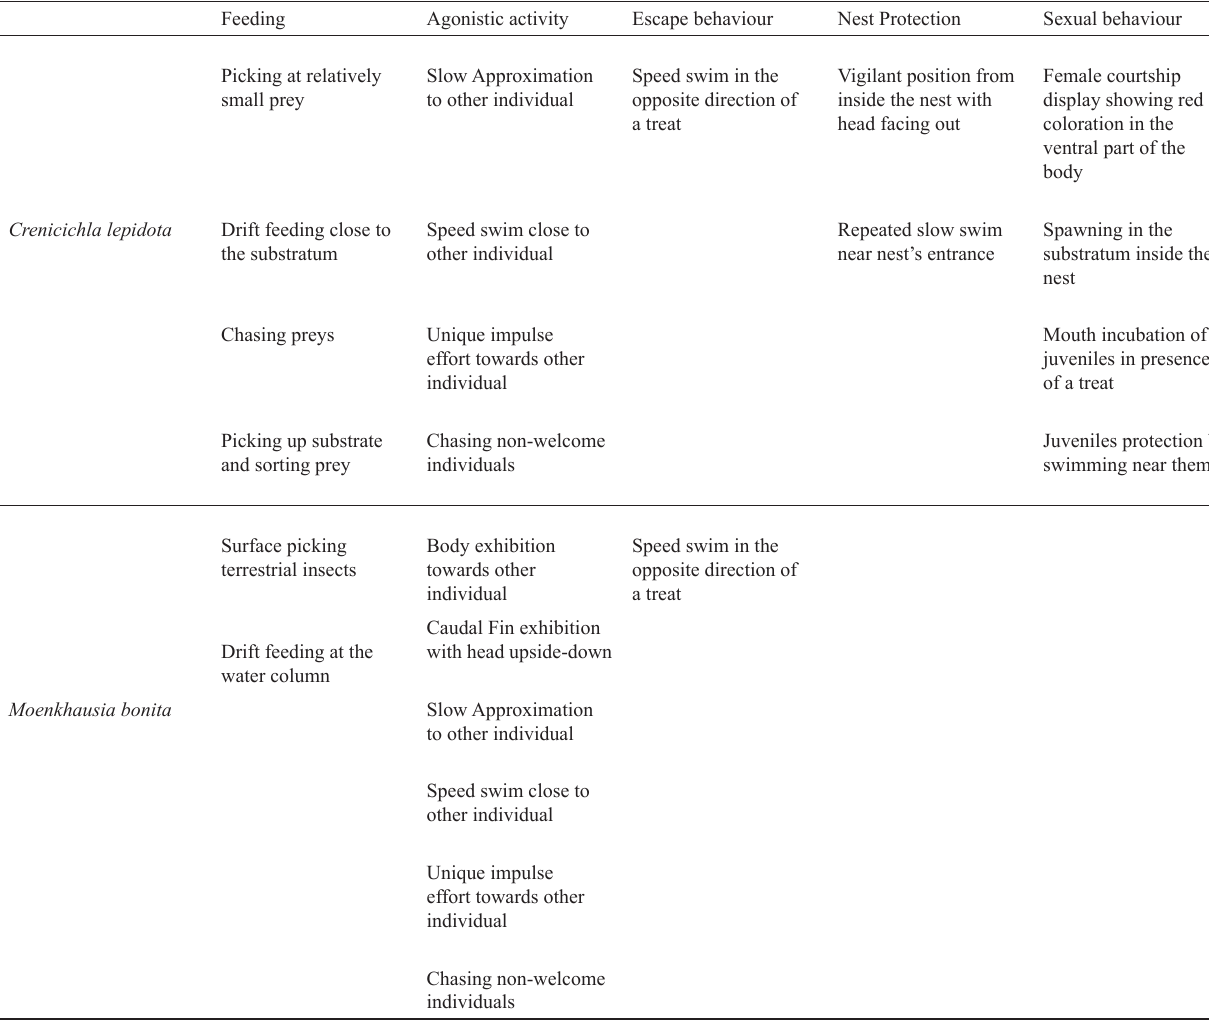
Table 1. Short description of behaviour categories defined for Crenicichla lepidota and Moenkhausia bonita